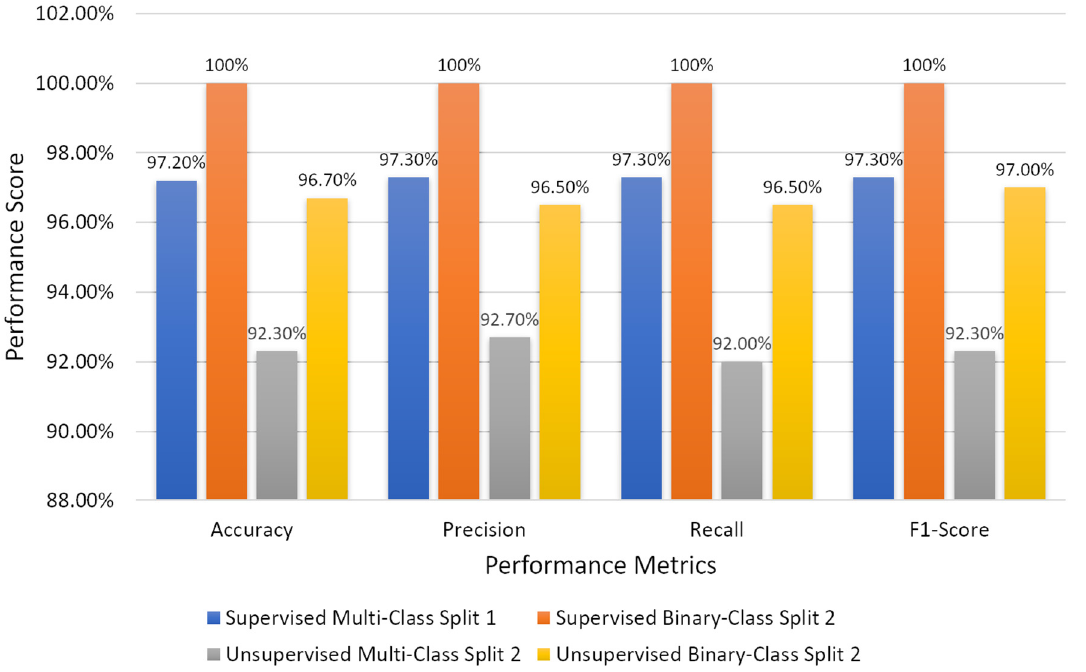
Figure 11. Bar chart of the overall performance scores of supervised and unsupervised